Question: What style of plot is this figure drawn as?
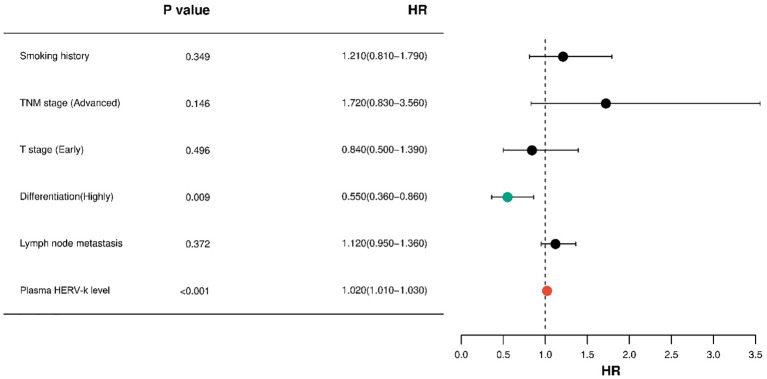
Answer: forest